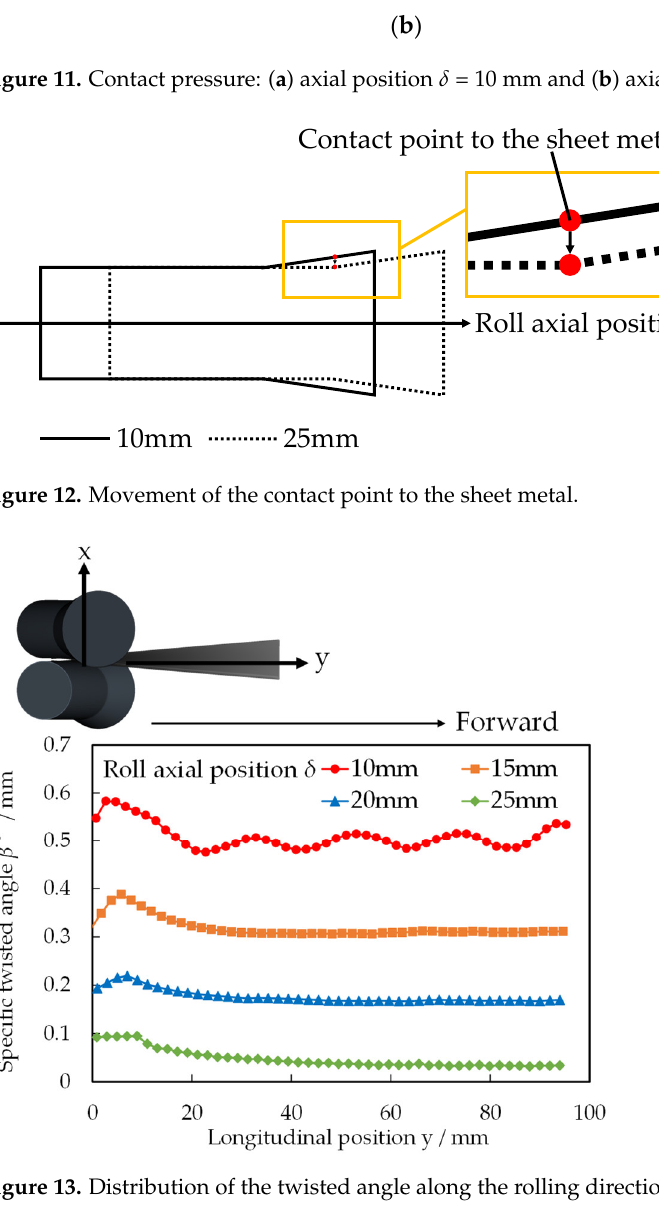
Figure 13. Distribution of the twisted angle along the rolling direction (FEA).